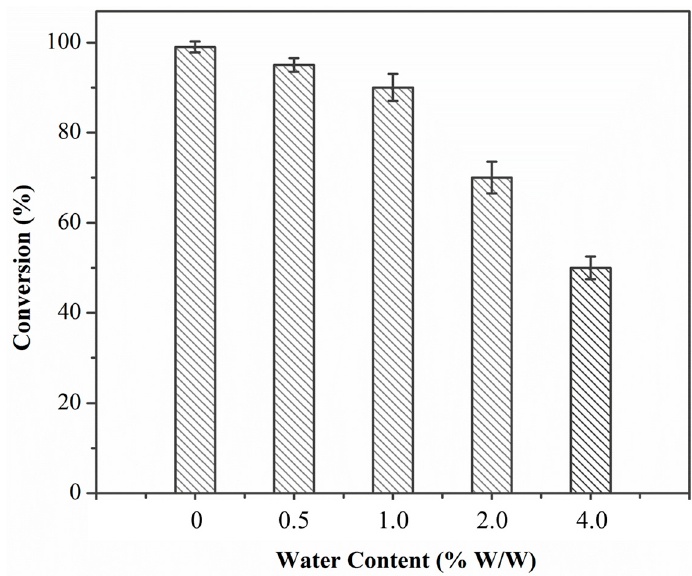
Figure 5. Water content effect on the conversion of chloramphenicol. Reaction conditions: enzyme loading 4.0 g L − 1 ; chloramphenicol 0.25 M in 1,4-dioxane; vinyl propionate/chloramphenicol = 5:1; T = 50 °C; 8 h and 200 rpm.